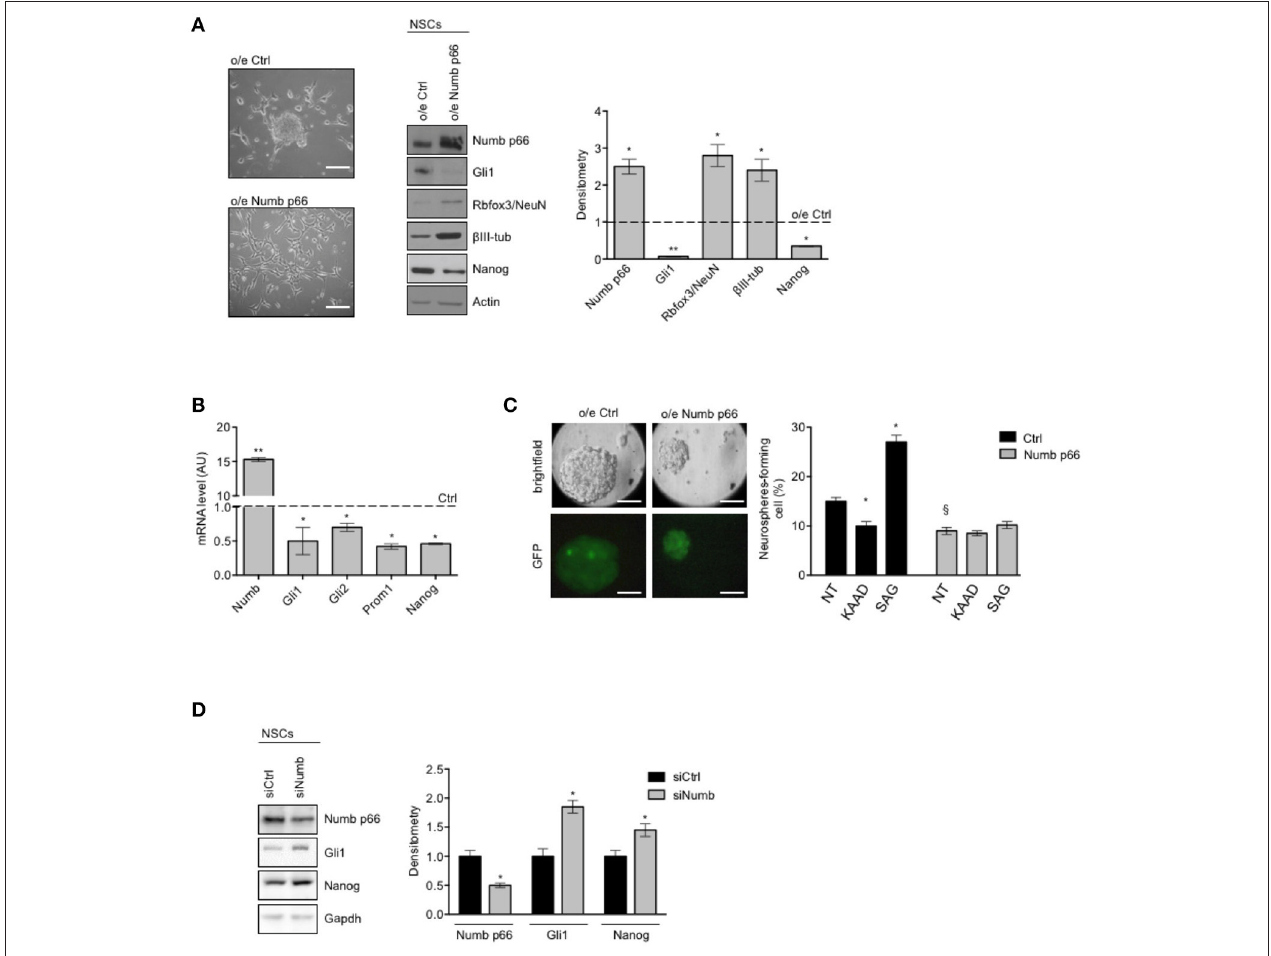
FIGURE 2 | Numb antagonizes stemness and promotes differentiation of cerebellar NSCs. (A) (Left) Representative bright-field images of neurospheres after overexpression of p66 (or Ctrl). Scale bar: 100 µ m. Representative western blot images (center) and densitometric analysis (right) of analysis of p66, stemness, and/or Hedgehog markers Nanog and Gli1 and differentiation markers Rbfox3/NeuN and β III-tubulin ( β III-tub), in NSCs after overexpression of p66 vs. Ctrl. Actin was used as loading control. P -values * p < 0.05. (B) mRNA expression levels of Numb p66 and stemness and/or Hedgehog markers (Gli1, Gli2, Prom1, and Nanog), in NSCs after overexpression of p66. Dashed bars represent control cells (Ctrl). Data are means ± SD from three independent experiments. P -values * p < 0.05; ** p < 0.01. (C) (Left) LvNumb-transduced NSCs were plated for clonogenic assay as described in Material and Methods. Upper panels show brightfield images of secondary neurospheres, lower panels show GFP of transduced cells. Scale bar: 100 µ m. (Right) Neurosphere-formation capacity of LvNumb-transduced NSCs and treated with cyclopamine-KAAD (KAAD) to suppress endogenous Hedgehog signaling or with Smo-agonist (SAG). Data are means ± SD from three independent experiments. * P -values (vs. NT), * p < 0.05. § P -value (vs. LvCtrl), § p < 0.05. (D) Representative Western Blot (WB) (left) and densitometric analysis (right) of NSCs before and after in vitro differentiation for 48h (PDGF); p66, Rbfox3/NeuN, Nanog were evaluated. Actin was used as loading control. P -values * p < 0.05. GAPDH was used as loading control. (A–D) Data are means ± SD from three independent experiments. Full-length images are presented in Supplementary Figures